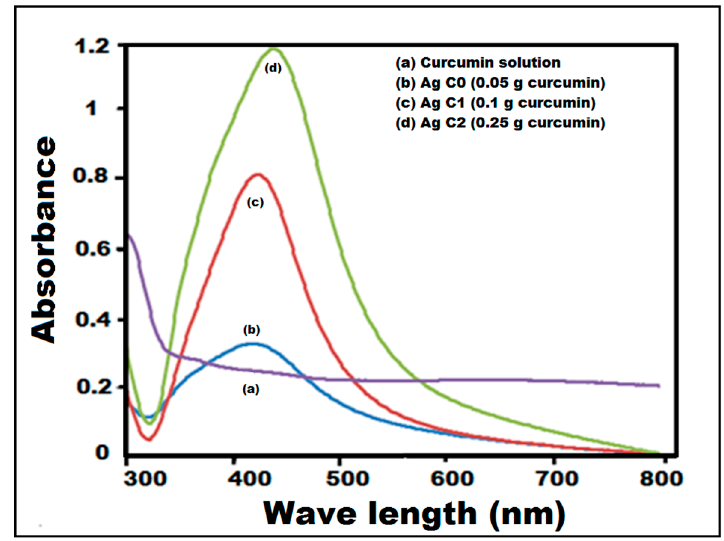
Figure 3. UV-visible absorption spectra for various concentrations of curcumin, i.e., Curcumin, C0, C1, and C2.